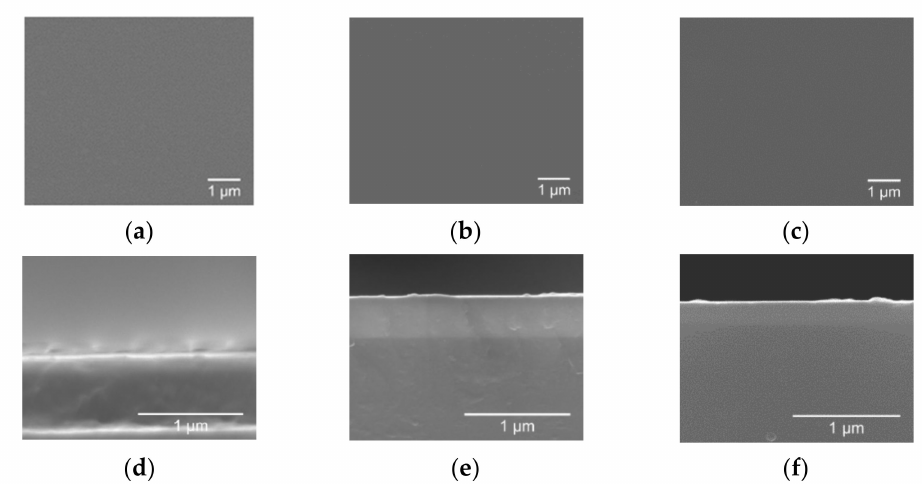
Figure 6. Surface SEM images of the second series of MoO x films grown on a silicon substrate with ( a ) 0.56 O 2 /Ar-60 min; ( b ) 0.56 O 2 /Ar-30 min; ( c ) 0.56 O 2 /Ar-15 min. Cross-section SEM images of the second series of MoO x films grown on a silicon substrate with ( d ) 0.56 O 2 /Ar-60 min; ( e ) 0.56 O 2 /Ar-30 min; ( f ) 0.56 O 2 /Ar-15 min.